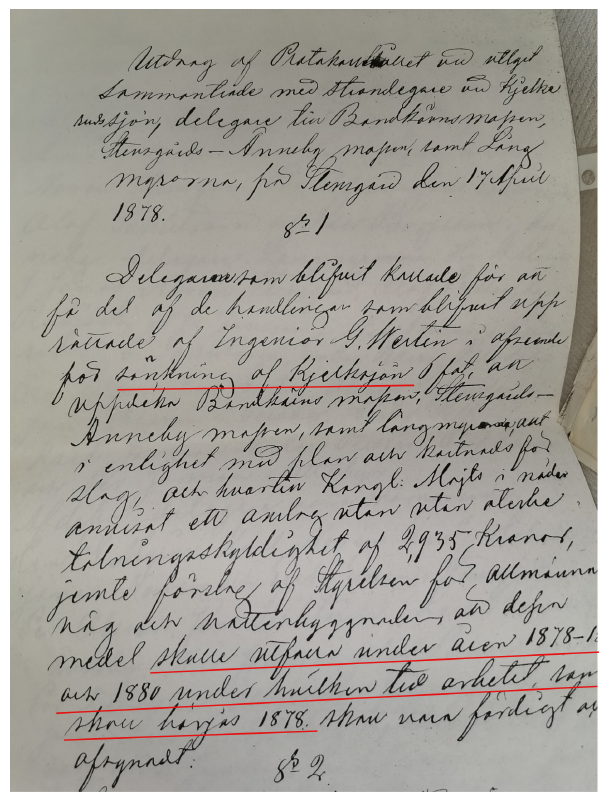
Figure 2. Historic document indicating that lake level lowering of Lake Kälksjön (avsänkning of Kjelksjön) was performed within the years 1878 to 1880CE (skulle utföra under aren 1878–1??? och 1880 ...) and that the work started in 1878CE (... under vilken tid arbetet som skulle börjas 1878). Source: local historian.